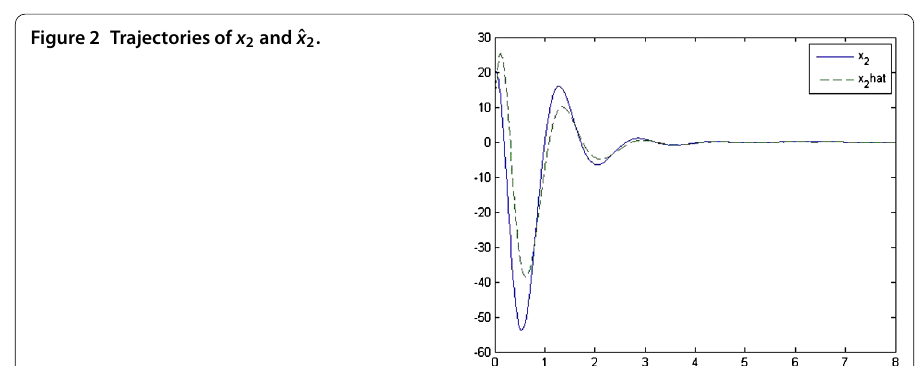
Figure 2 Trajectories of x 2 and ˆ x 2